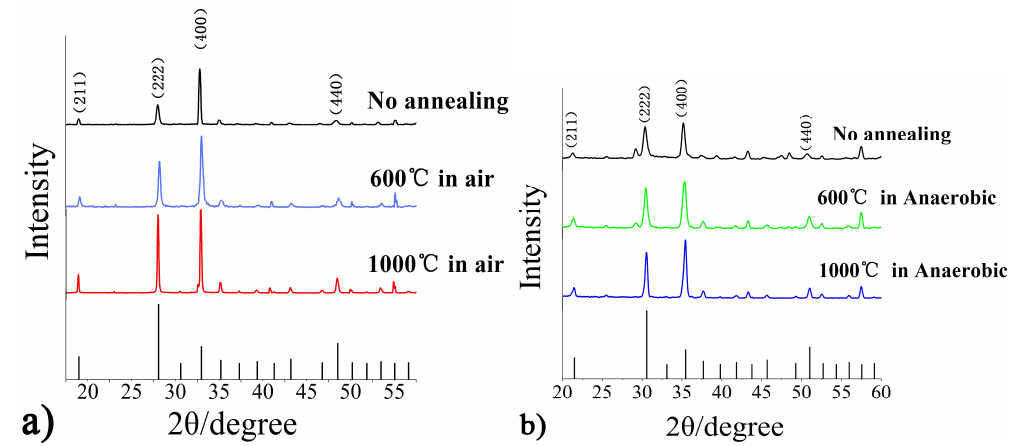
Figure 7. X-ray diffraction patterns of In 2 O 3 film under different annealing processes, ( a ) Annealing process at different temperatures with air environment treatment, ( b ) Annealing process at different temperatures with vacuum treatment.